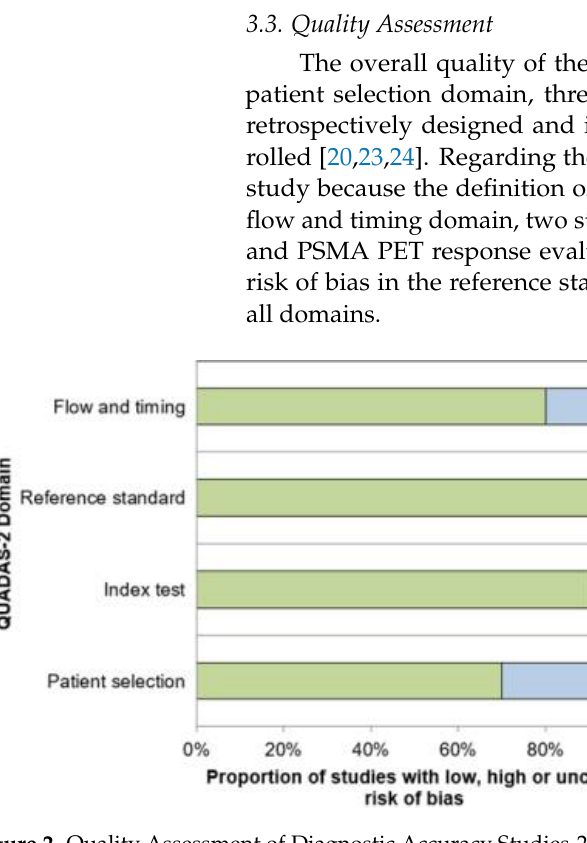
Figure 2. Quality Assessment of Diagnostic Accuracy Studies-2 (QUADAS-2) quality assessment of the 10 included studies.